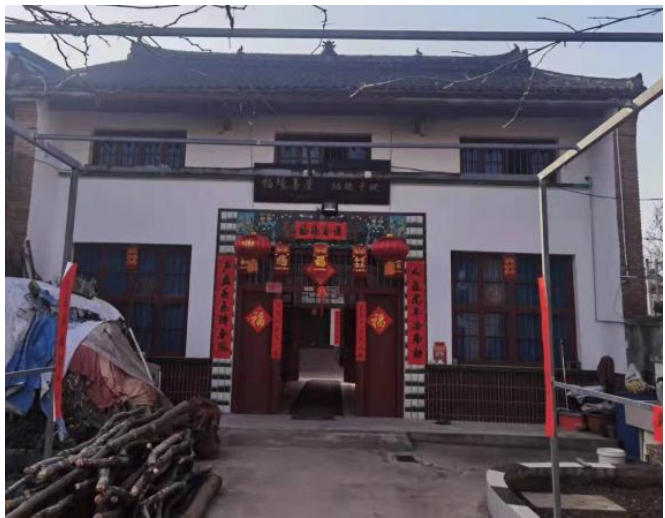
Figure 3. A village house in Xi’an.